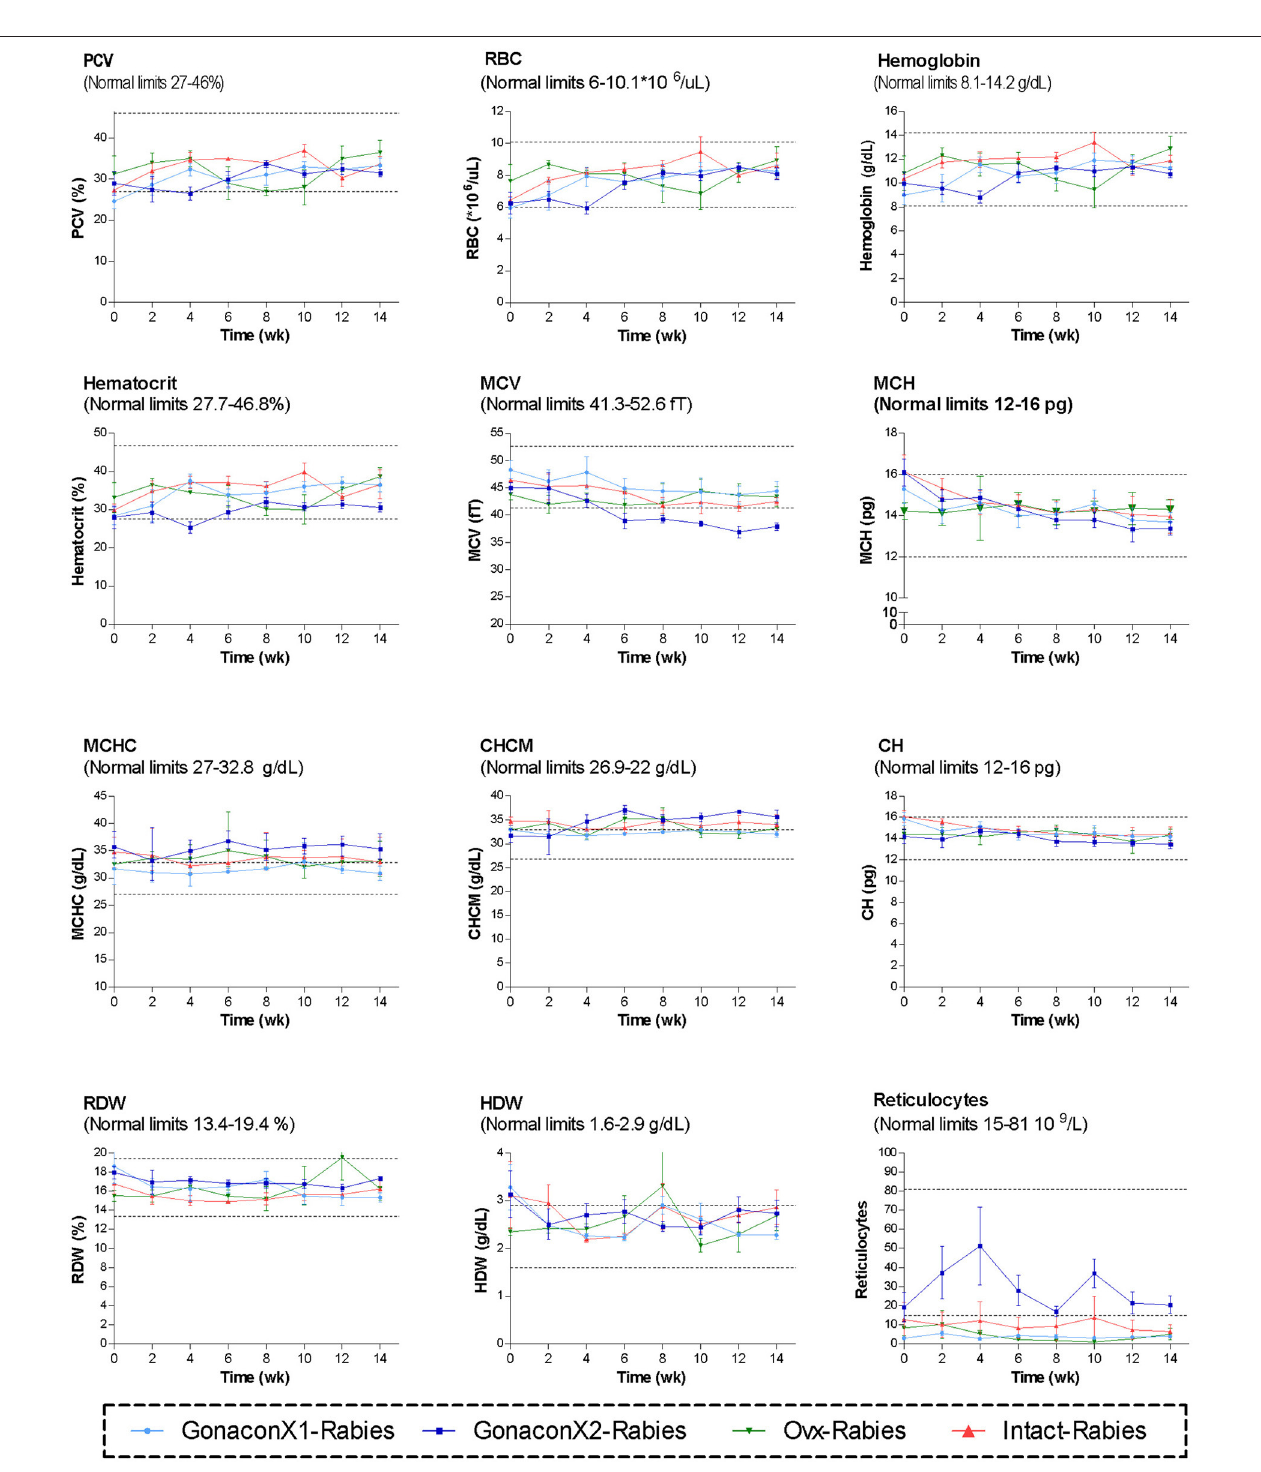
FIGURE 2 | Red blood cells parameters of cats in the research groups. Mean ± SEM of red blood cells parameters are presented for each group: GonaconX1-Rabies: cats vaccinated with both Gonacon and rabies ( n = 5); GonaconX2-Rabies: cats vaccinated twice with Gonacon (3 weeks apart) and with rabies ( n = 4); OVx-Rabies: cats ovariohysterectomized and vaccinated with rabies ( n = 4); Intact-Rabies: cats vaccinated against rabies and remained intact ( n = 3). Blood samples were collected every 2 weeks for a total of 14 weeks. Dotted lines indicate normal limits. PCV, packed cell volume; RBC, red blood cell count; MCV, mean corpuscular hemoglobin; MCH, mean corpuscular hemoglobin concentration; MCHC, mean corpuscular hemoglobin concentration; CHCM, cell hemoglobin concentration mean; CH, cellular hemoglobin; RDW, red cell distribution width; HDW, hemoglobin distribution width.